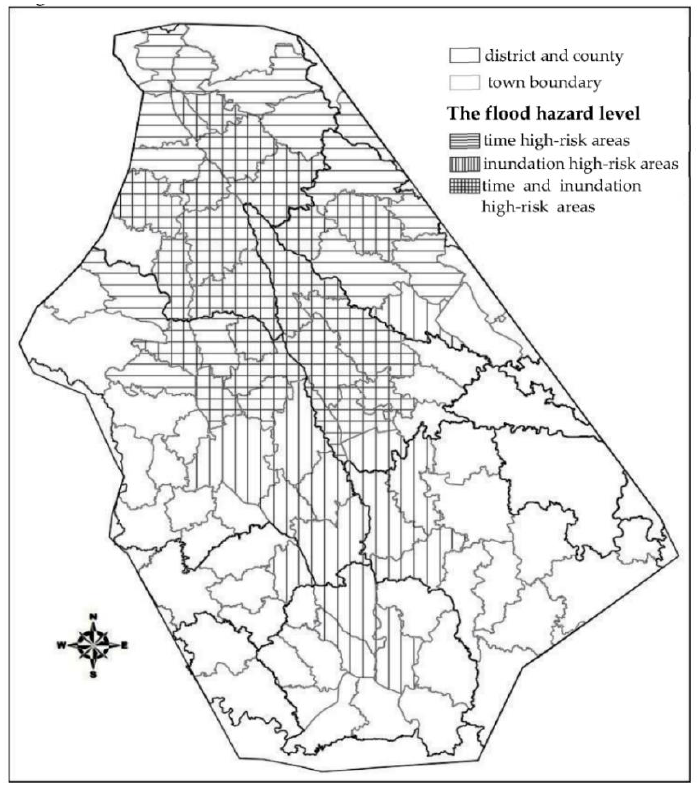
Figure 11. Dam-flood hazard map.